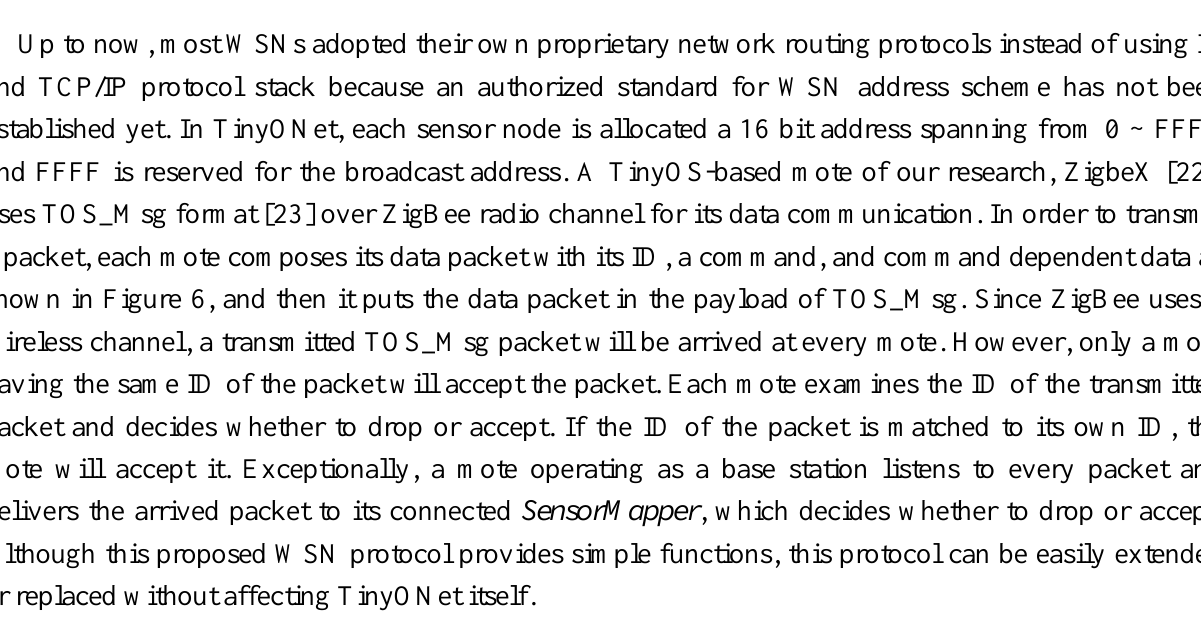
Figure 7. Processing of a REGISTER packet transmitted from a sensing